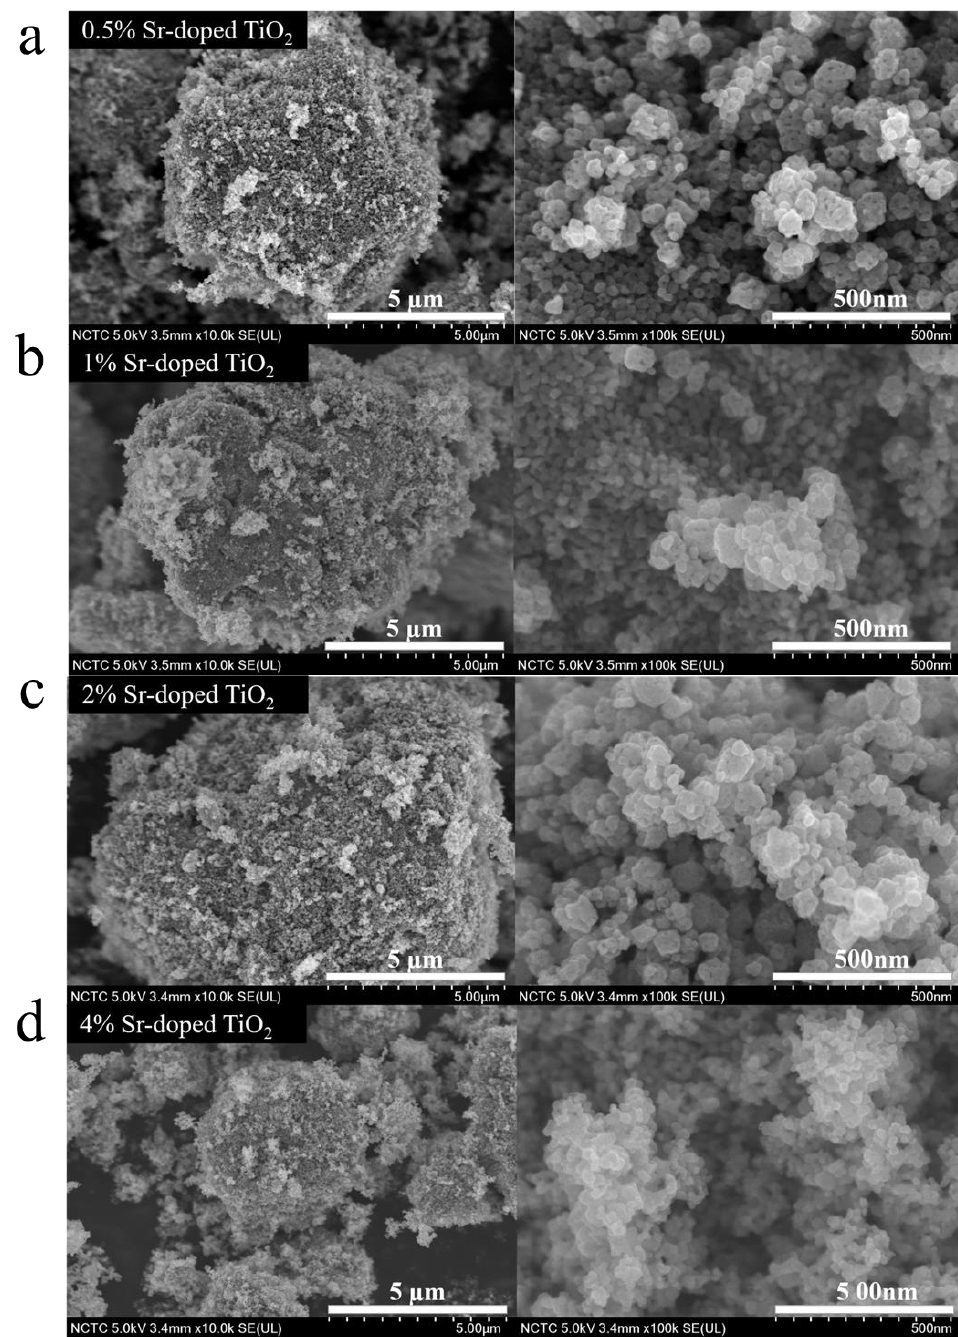
Figure 3. FE-SEM images at low (left side) and high (right side) magnifications of ( a ) 0.5% Sr-doped TiO 2; ( b ) 1% Sr-doped TiO 2; ( c ) 2% Sr-doped TiO 2; ( d ) 4% Sr-doped TiO 2 . Table 2. Elemental composition of Sr detected from EDS analysis of Sr-doped TiO 2 photocatalysts.